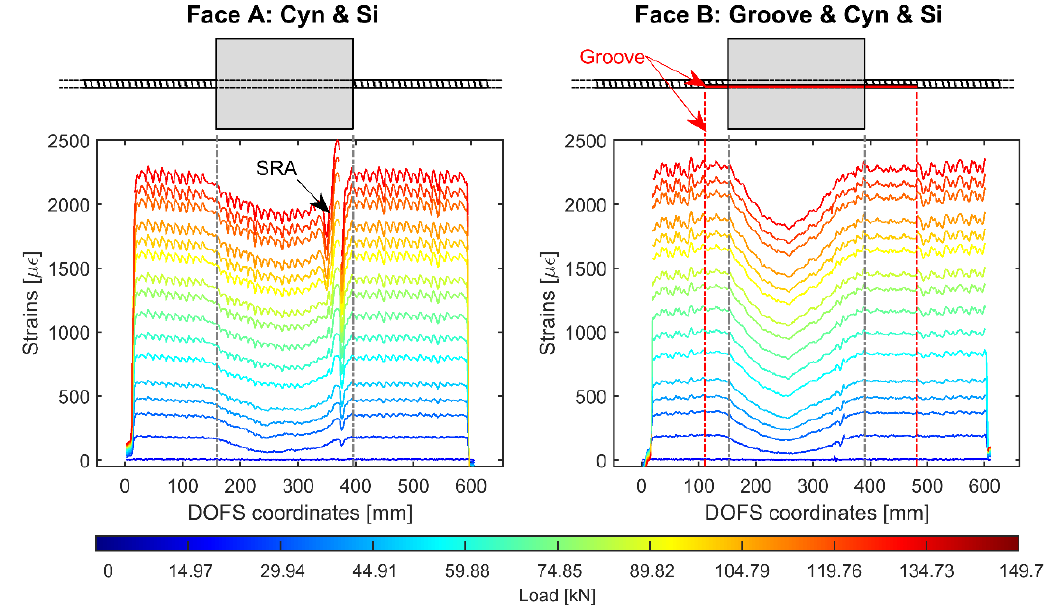
Figure 16. Strain profiles of 15D20_24_2 RC tie test with the DOFS bonded on both sides of the rebar by means of CYN and SI on one side (Face A— left ) and a groove + CYN + SI on the other (Face B— right ).